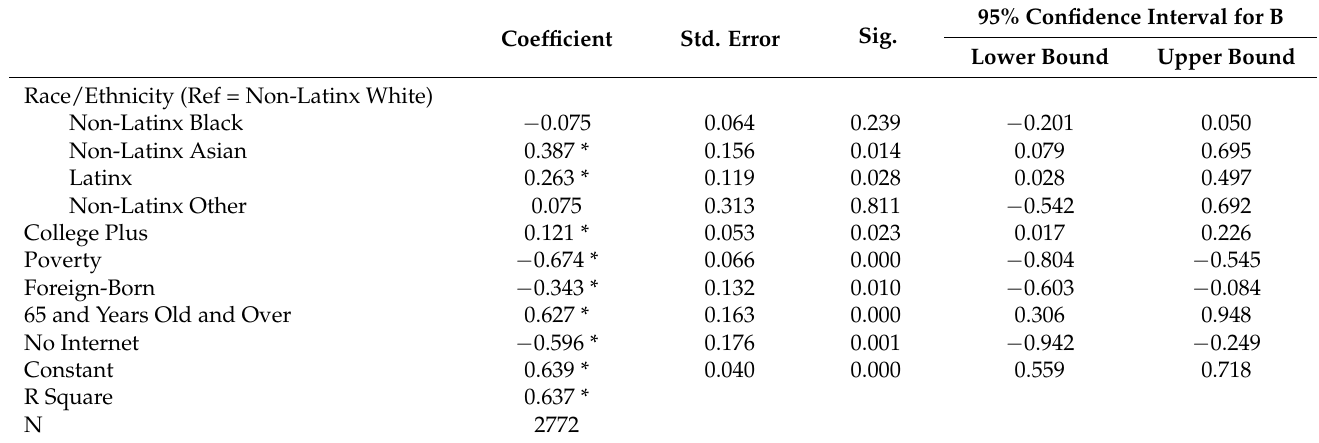
Table 2. Multiple regression results predicting COVID-19 vaccination coverage